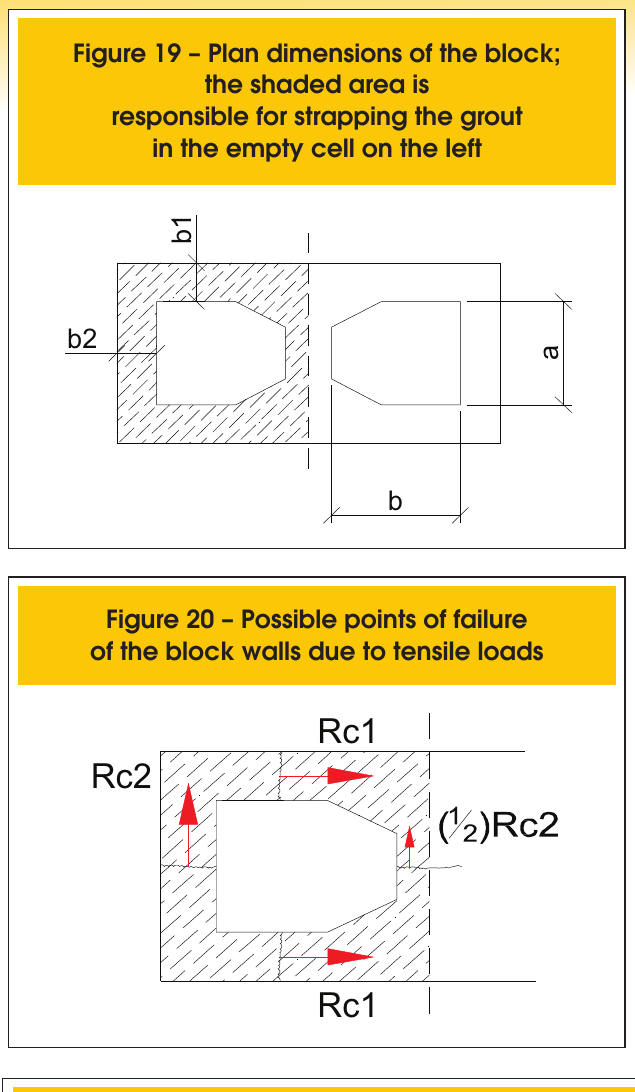
Table 9 – Comparison of mean theoretical and experimental loads for some strains (Model III – 2.0‰) LOADS ON THE PRISMS